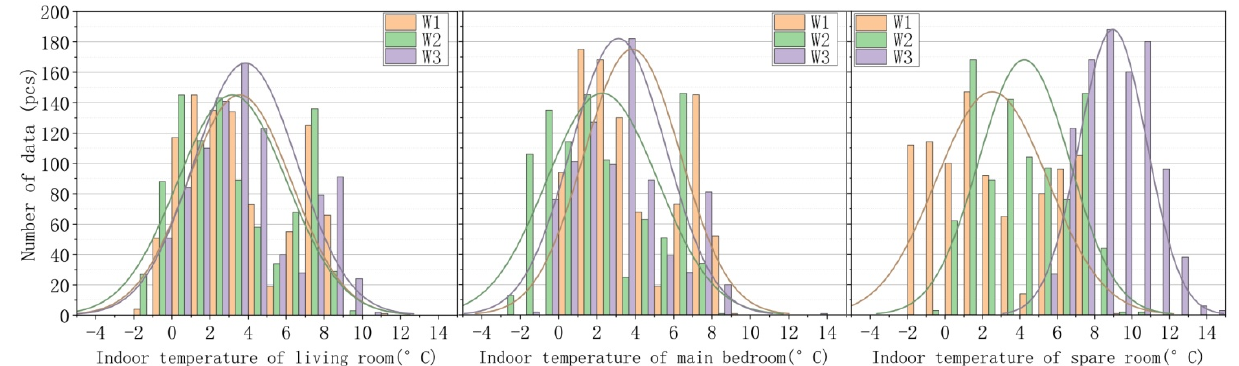
Figure 21. Distribution of indoor temperature data in winter.